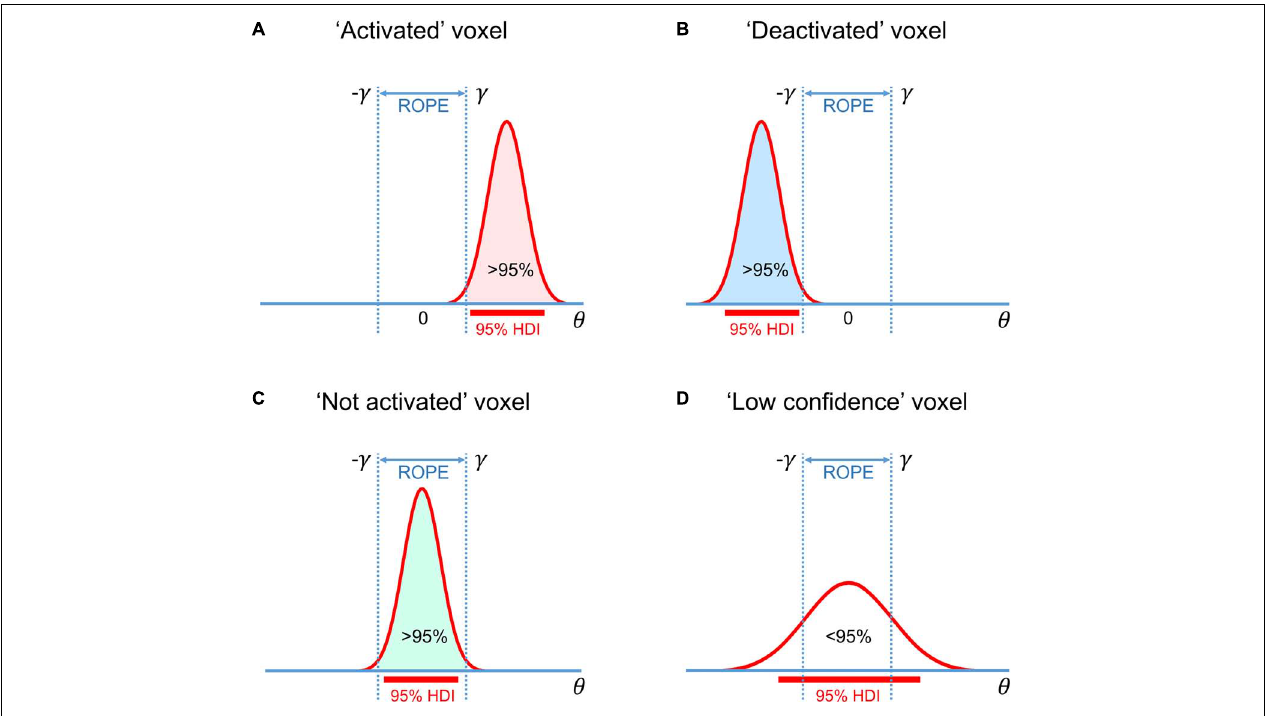
FIGURE 4 | Possible variants of the posterior probability distributions of the effect θ = c β in (A) ‘activated’ voxels, (B) ‘deactivated’ voxels, (C) ‘not activated’ voxels, (D) ‘low confidence’ voxels. The ‘ROPE only’ rule considers only the colored parts of the distributions. The ‘HDI+ROPE’ rule considers overlap between the ROPE and 95%